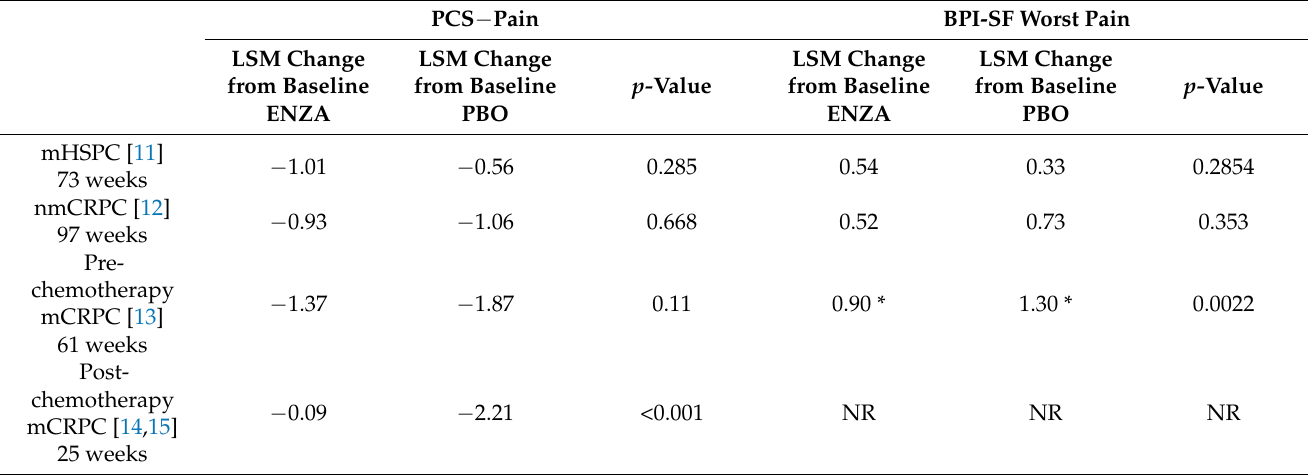
Table A3. Change from BL in pain